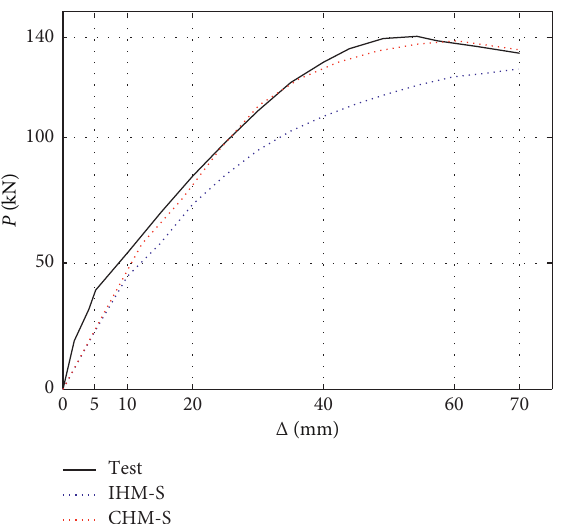
Figure 17: Comparison between the skeleton curves from the experiment and those obtained by